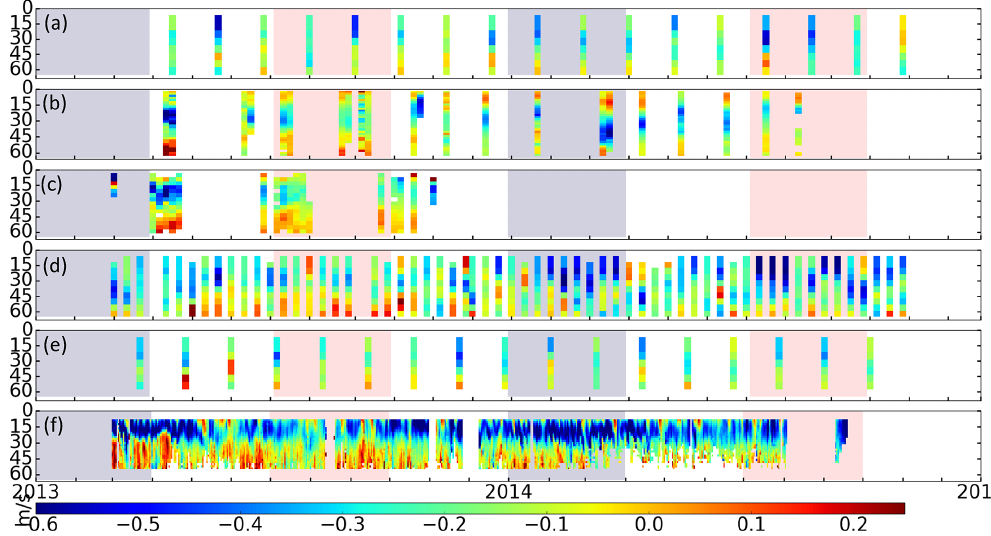
Figure 4. Time–space diagrams of the current velocities derived from (a) SARAL track 887, (b) ADCP, (c) gliders, (d) Jason-2 track 222, (e) SARAL track 302, and (f) HF radars between March 2013 and October 2014. The pink and grey areas in the background of the diagrams correspond to the summer and winter seasons,